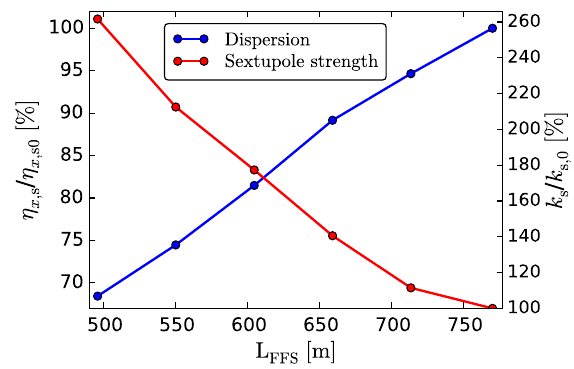
FIG. 22. Average sextupole strength and dispersion at the sextupole locations as a function of the FFS length.